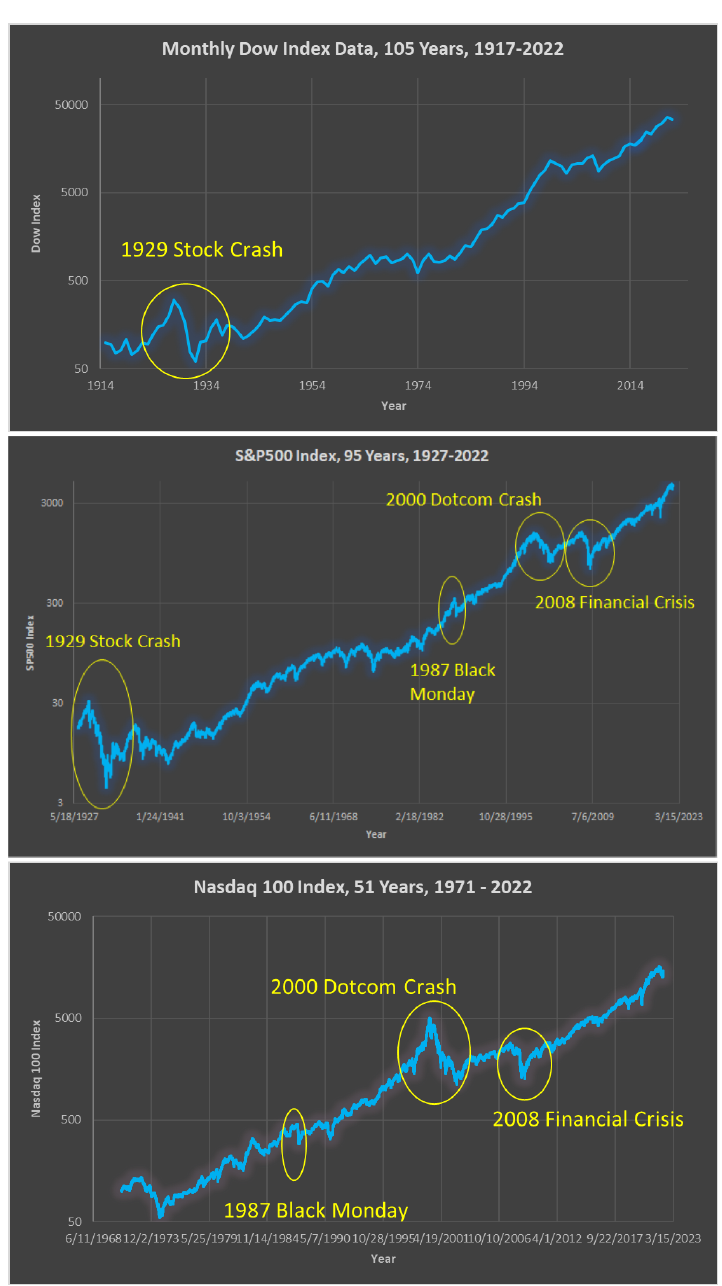
Figure 6. A remarkable century of markets and growth, even through the Depression and World Wars: ( top ) 105 years of the Dow; ( middle ) 95 years of the S&P500; ( bottom ) 51 years of the Nasdaq index; data from (macrotrends